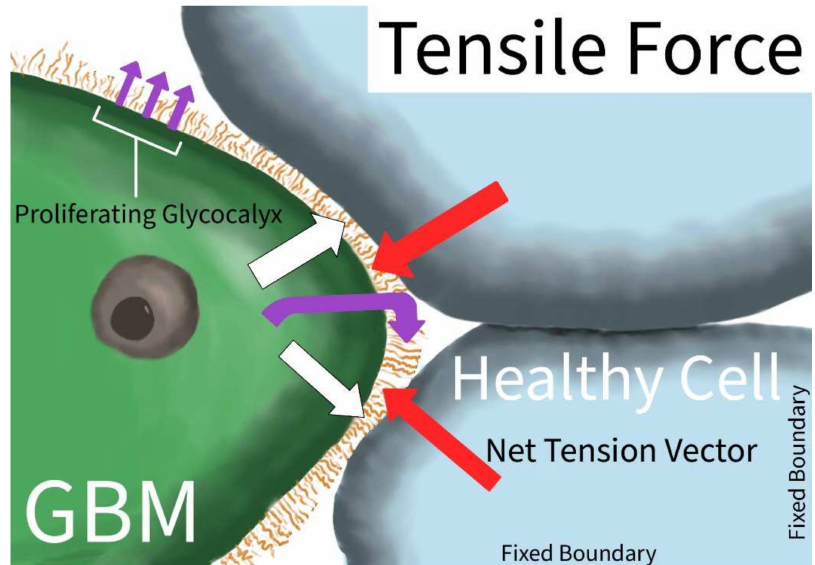
Figure 2. Tensile Force in GBM. Tension vector (white arrow) applied to GBM cell exerts force on the GBM cell membrane, and in response, the GBM produces an extracellular glycocalyx matrix (purple curved arrow) leading to matrix growth (purple straight arrow); the glycocalyx matrix can pull on the surrounding healthy tissue, inducing net tensile force at the leading borders of the GBM (red